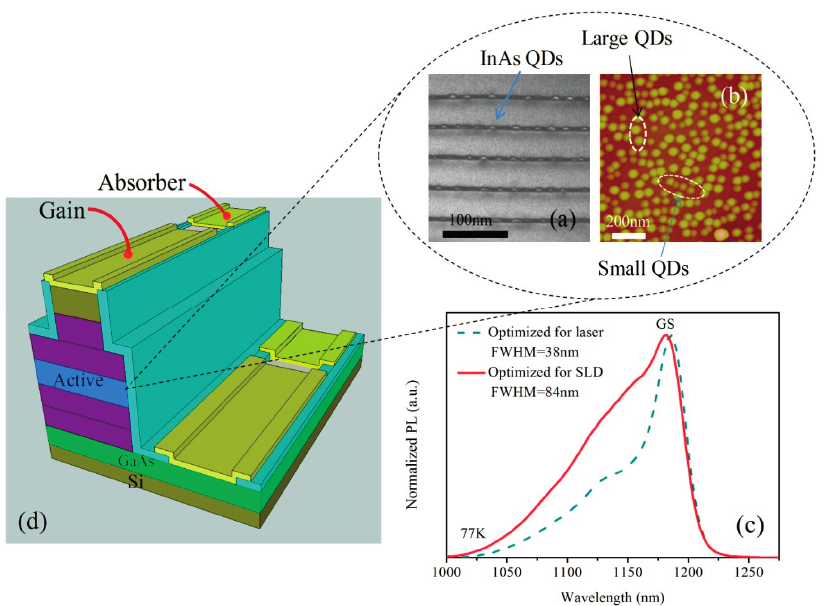
Figure 6. ( a ) Cross-sectional TEM image for the active region of the InAs QD grown on Si substrates. ( b ) AFM image of uncapped InAs QDs optimized for broad linewidth. ( c ) Normalized PL spectra of InAs QDs with the growth conditions optimized for